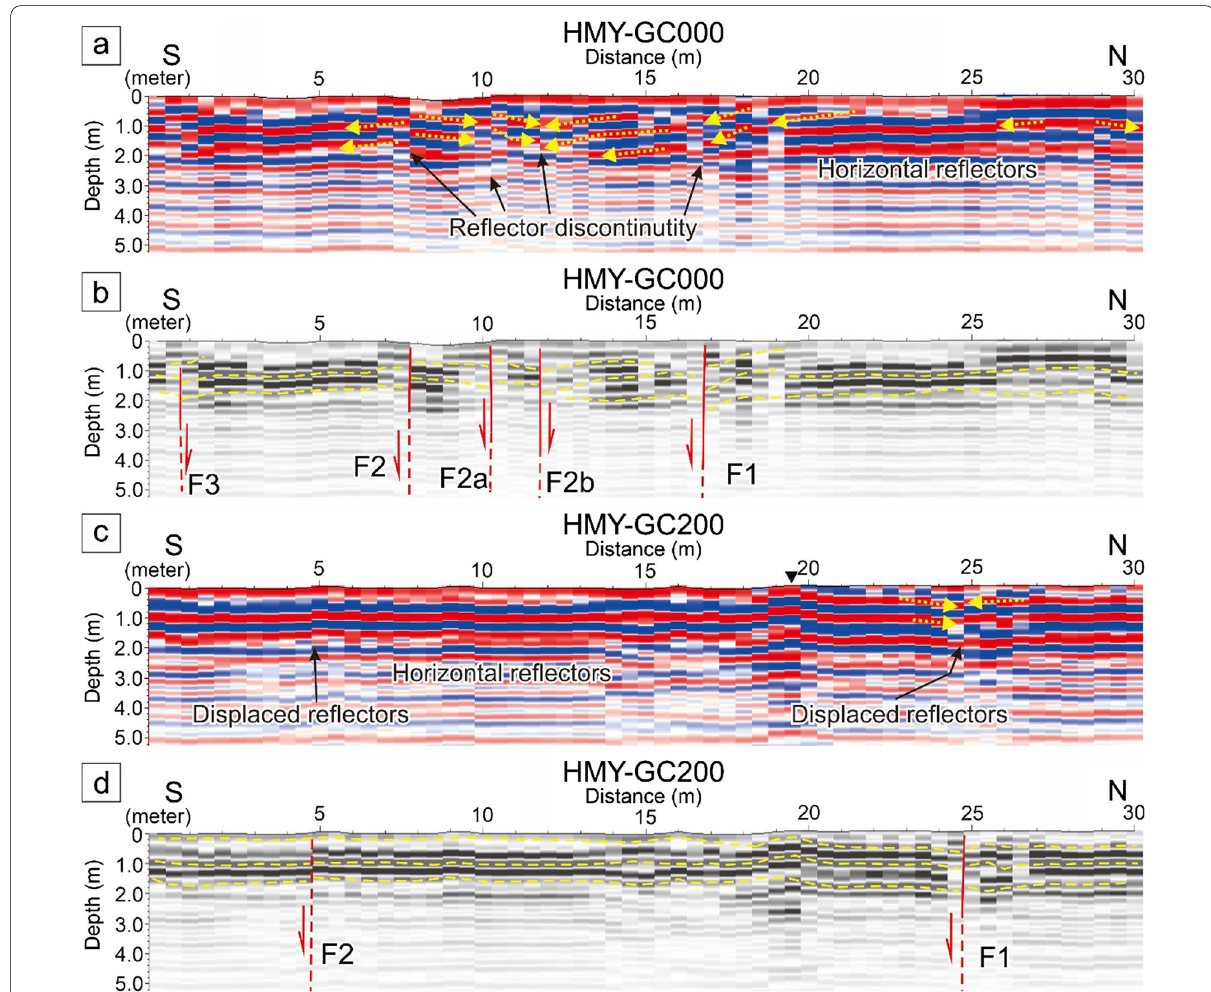
Fig. 8 a Processed GPR sections of the HMY-GC000. b Interpretation of the HMY-GC000. c Processed GPR section of the HMY-GC200. d Interpretation of the HMY-GC200. The dashed yellow line indicates the trace of reflectors. The yellow dotted arrow indicates the dip of reflectors. Black triangles mark the concrete structures at the